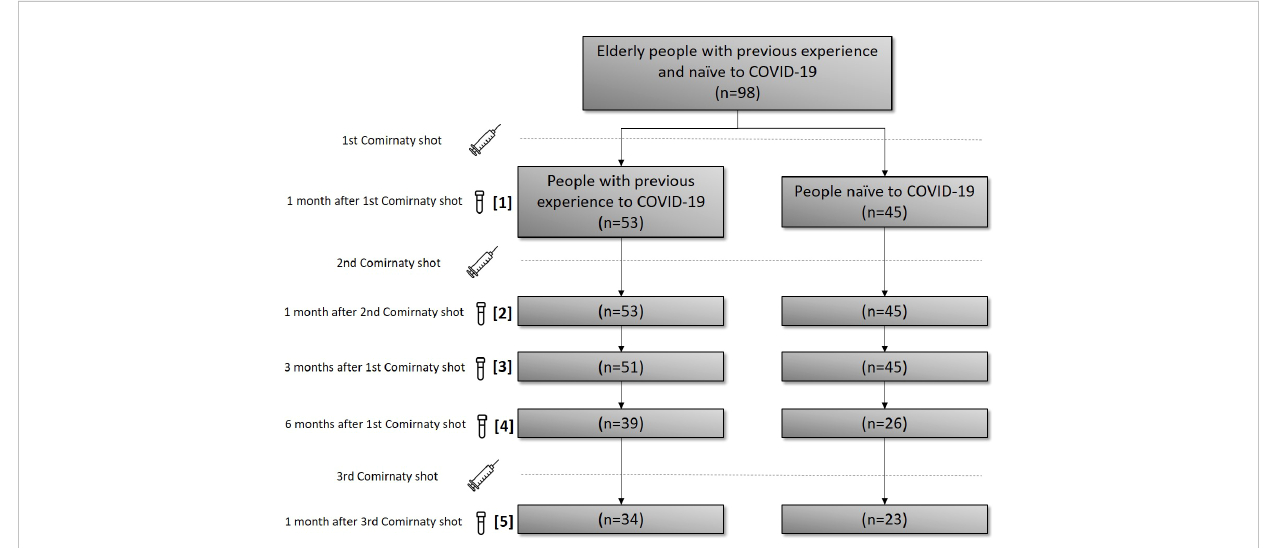
FIGURE 1 CONSORT diagram for patient selection, sampling dates and allocation. In brackets, the consecutive sampling number is described for